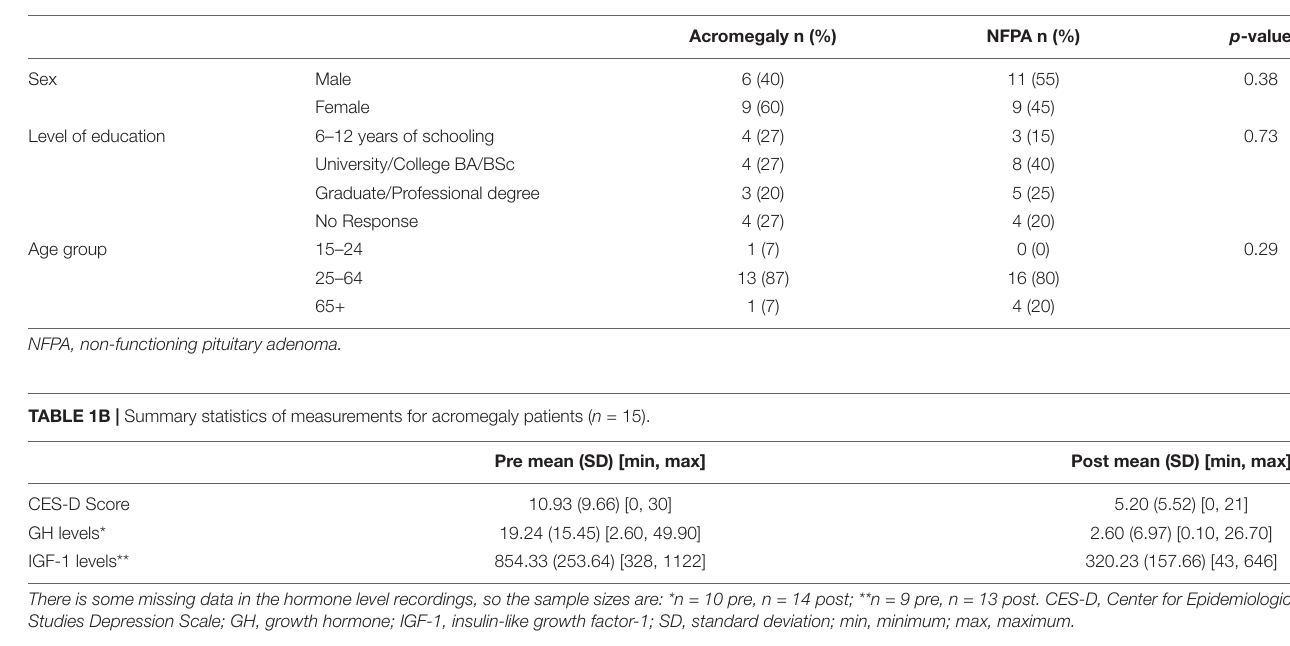
TABLE 1A | Demographic information for acromegaly ( n = 15) and NFPA ( n = 20) patients.